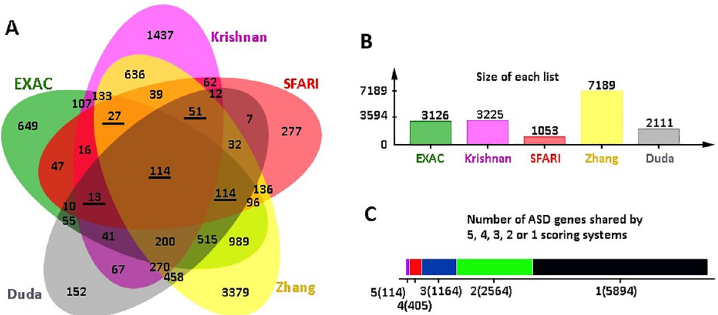
Fig 2. Shortlisting of common ASD factors. (A) JVenn Diagram of all overlapping genes from the scoring systems used. Underlined numbers indicate sets overlapped with SFARI. (B) Size of each set of shortlisted genes. (C) The number of genes that are shared by or specific to the